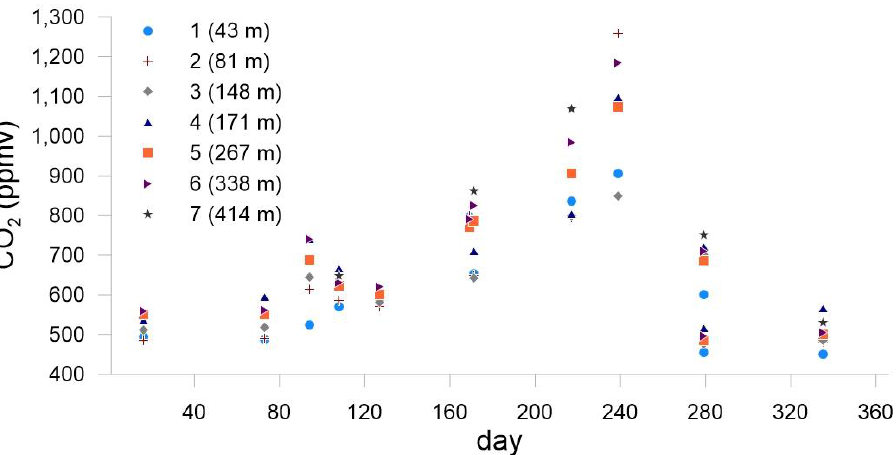
Figure 11. Spot air CO 2 concentrations data, measured inside Sant’Angelo cave in the period 2005– 2007. Time is expressed as the ordinal of the day of the year of acquisition of each measure. Progressive distances of the points from cave entrance are reported between round brackets (see also Figure 4 for point locations).